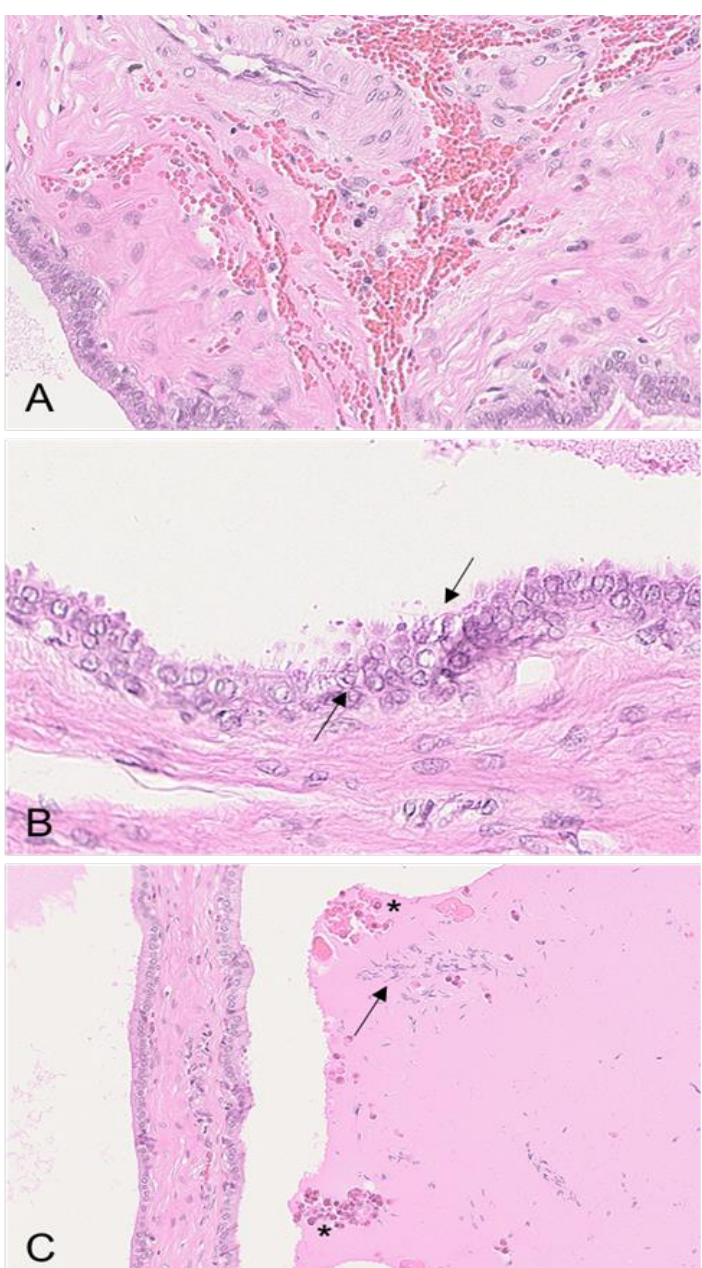
Figure 6. Histopathological changes in the vesicular gland of ASFV-infected boars. ( A ) HE, boar #2; hemorrhage expanding the gland interstitium. ( B ) HE, boar #4; degeneration of the glandular columnar epithelium, characterized by flattening and apoptosis/necrosis of single cells (arrow). ( C ) HE, boar #3; the lumen was filled with proteinaceous fluid admixed with cellular debris (asterisk) and several spermatozoa